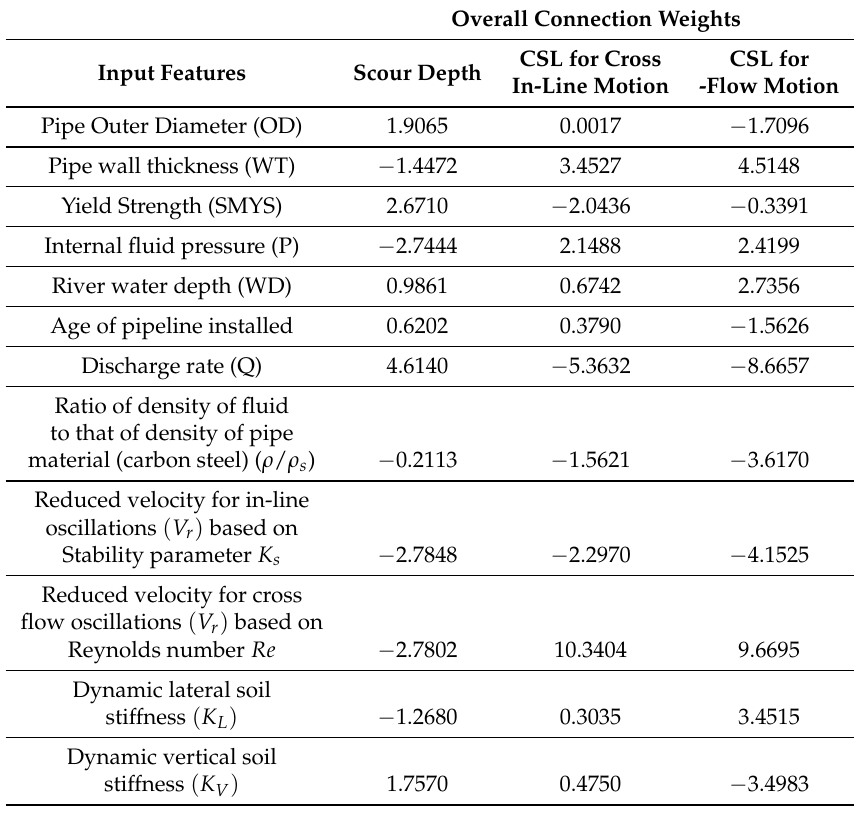
Table 7. Overall Connection Weights of Input parameters based on Olden’s approach